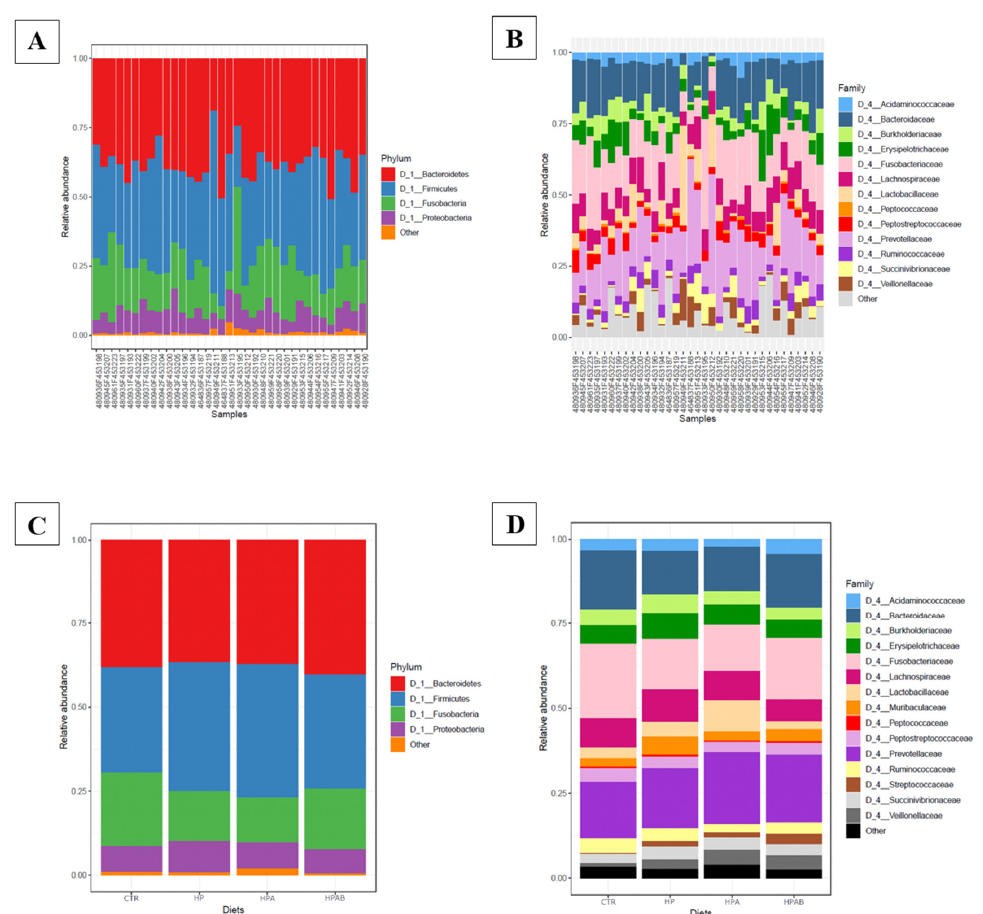
Figure 4. ( A ) Bar plot of the main phyla detected in faecal samples; ( B ) Bar plot of the main families detected in faecal samples; ( C ) Bar plot of the main phyla described for each dietary treatment; ( D ) Bar plot of the main families described for each dietary treatment.